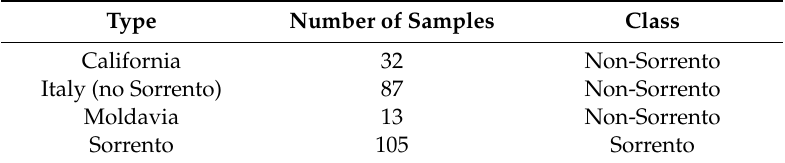
Table 1. Provenance of the examined walnuts